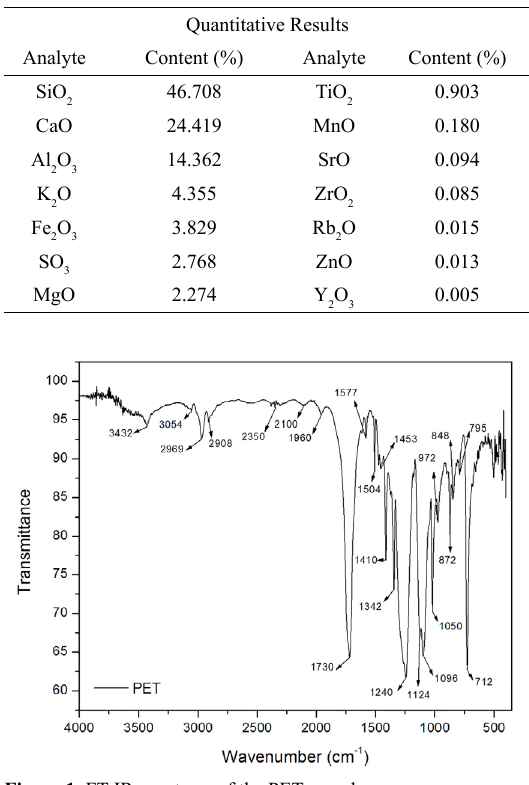
which shows the overlay of the untreated and treated